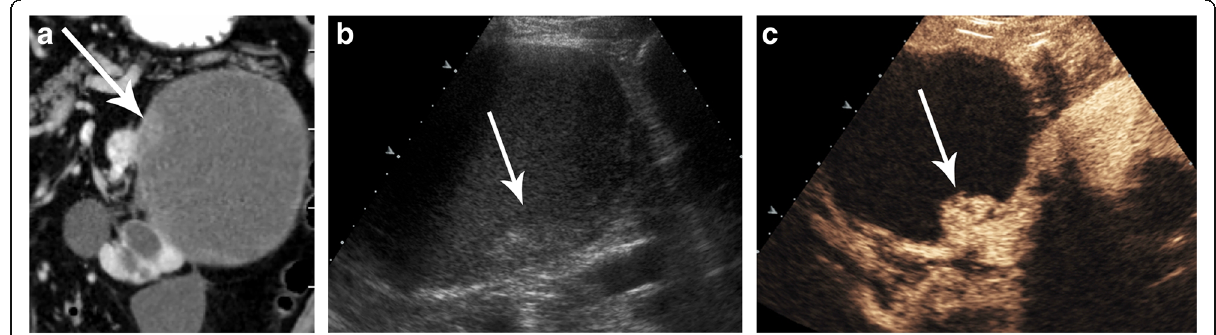
Fig. 19 Contrast-enhanced US image showing a cystic renal lesion in the wall of the left kidney suspected of being a solid lesion. a Coronal contrast-enhanced CT showing a cystic renal mass with a hard-to-define image in its wall (arrow). c Unenhanced and ( d ) contrast-enhanced US clearly depicting enhancement on this solid nodule (arrows) in the cyst wall, leading to the lesion being defined and classified as a